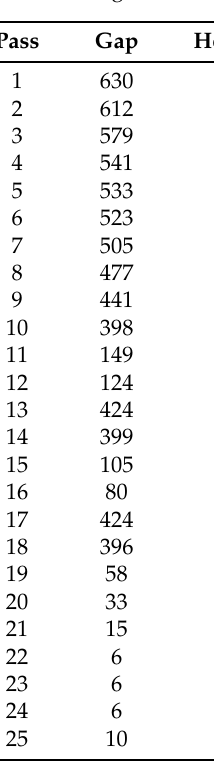
Table 2. Rolling schedule used in IPR profile manufacturing, gap in